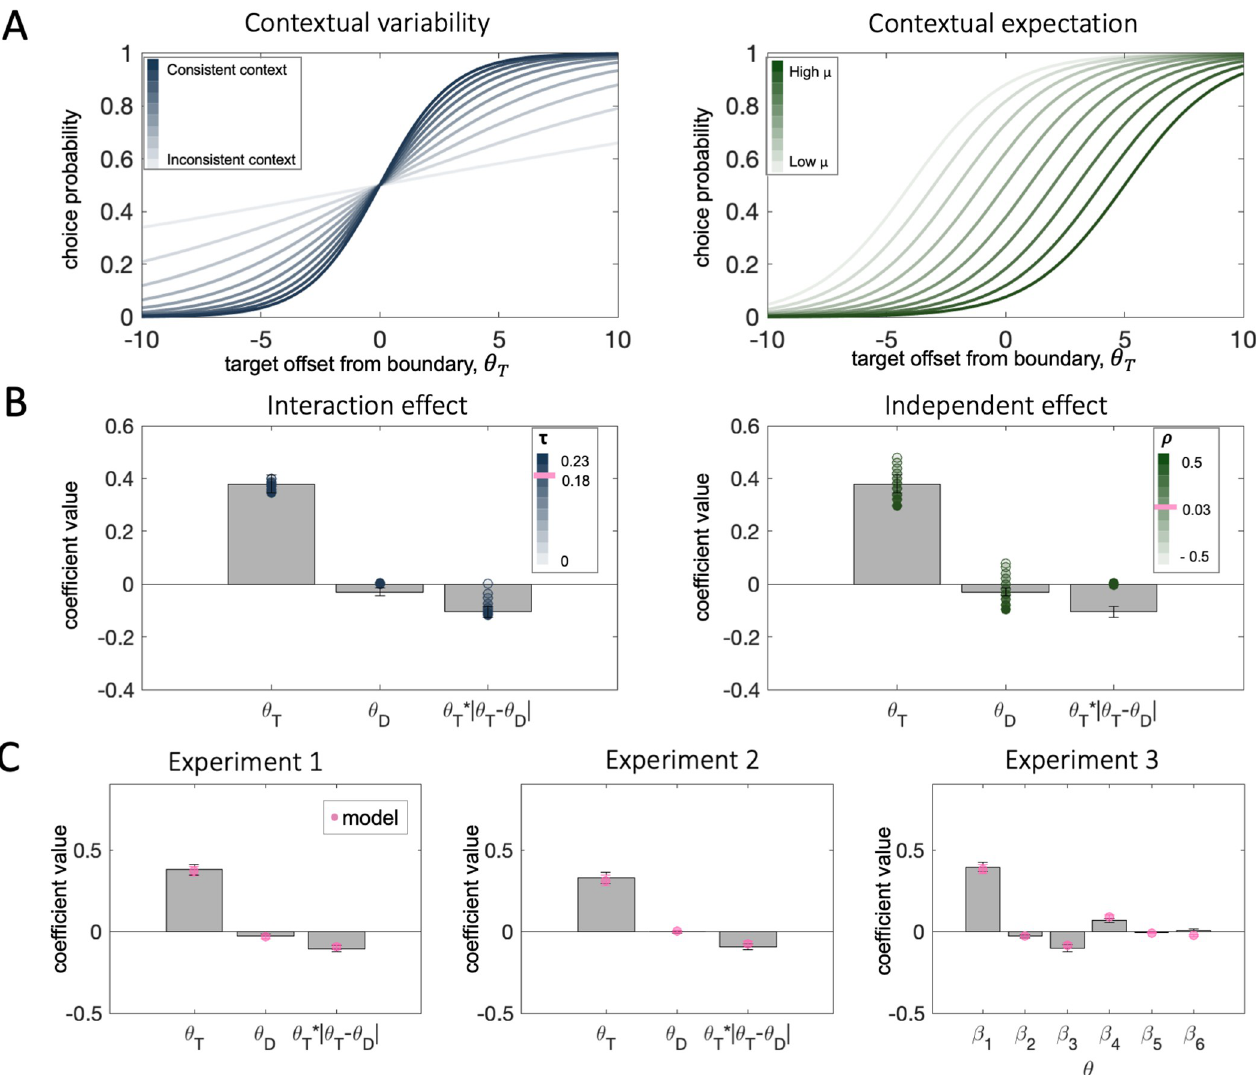
Fig 5. A. The effects of context on the transducer function translating decision inputs into choice probabilities. Left : The consistency of context changes the slope of the transducer. Lower contextual variability leads to steeper slope (darker blue curves) and vice versa for high variability (lighter blue curves). Right: The contextual expectation changes the location of the inflection point of the transducer. A high contextual average leads to a transducer shifted rightwards along the x-axis (darker green curves) and vice versa for low contextual average. B. The impact of context on the distracter effects in choice behaviour. Left: Contextual variability leads to an interaction effect of the distracter (target-distracter consistency). Bars correspond to coefficients from a regression on human choices from Exp.1, filled circles correspond to an analogous regression on model simulations where we varied parametrically the value of τ ,while keeping ρ and r constant. The higher the value of the multiplicative free parameter τ , the stronger the consistency effect (darker circles). The pink line depicts the average estimated value of τ for Exp. 1. Right: The contextual expectation leads to an independent effect of the distracter. Bars correspond to coefficients from a regression on human choices from Exp.1, filled circles correspond to an analogous regression on model simulations where we varied parametrically the value of ρ , while keeping τ and r constant. The higher the value of the multiplicative free parameter ρ , the stronger the repulsion from the distracter (darker circles). The pink line depicts the average estimated value of ρ for Exp. 1. C. Model fits to human data. Across all three experiments bars correspond to coefficients from a regression on human choices and pink circles correspond to model-simulated choices with free parameters estimated to best fit human data. Error bars correspond to standard errors of the mean. Coefficient labels in experiment 3 are as in Fig 4C .